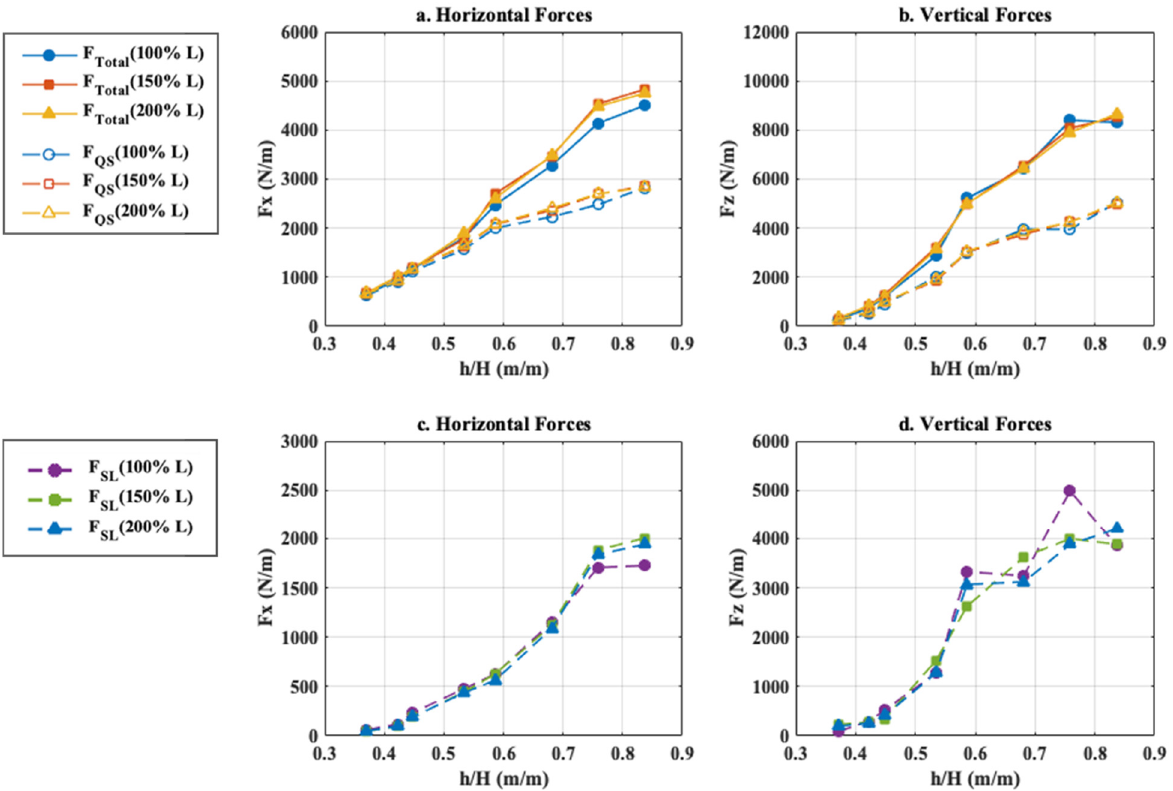
Figure 18. Comparisons of numerically predicted maximum wave forces for different deck widths.